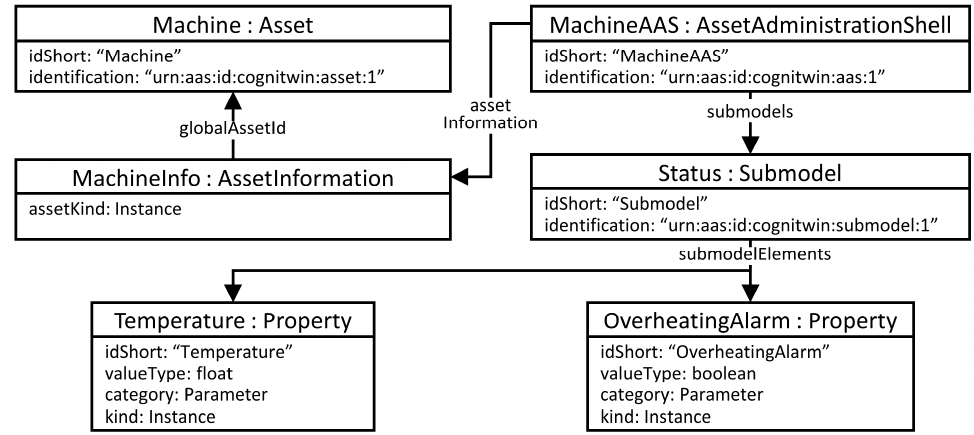
Figure 3. Simplified UML Object Diagram of the demonstrator Asset Administration Shell.